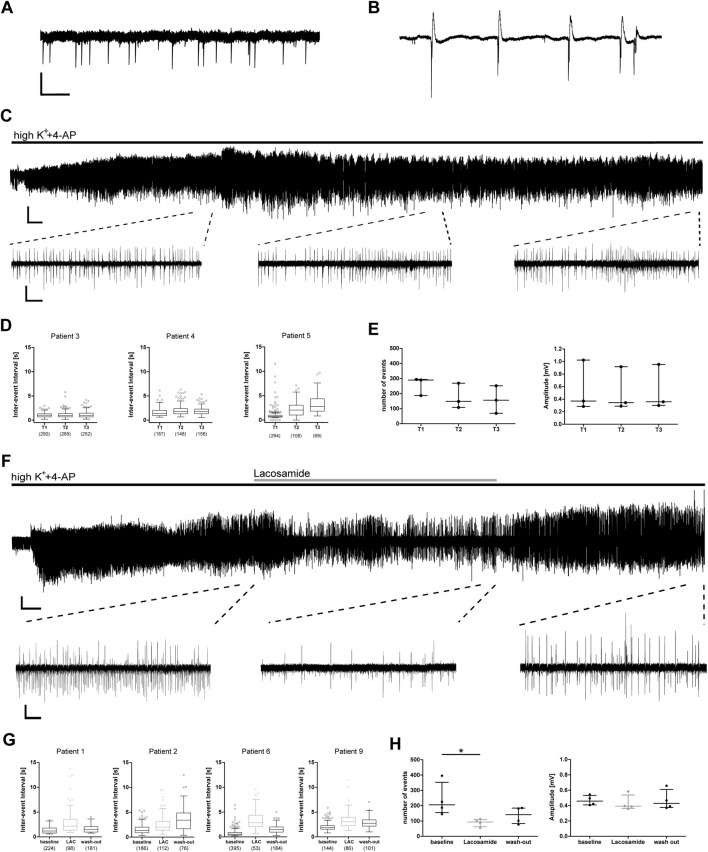
Epileptic burst activity in human slices is stable over long time periods and decreases during application of lacosamide. Application of 8 mM K+ and 100 μM 4-aminopyridine (4-AP) induces two patterns of network activity recorded by field potential electrodes in the CA1 area of human hippocampal slices: interictal spikes (A) and burst activity (B). (C–E) Burst activity is induced a few minutes after application and stable for at least 60 min. (F–H) Induced burst activity decreases during application of lacosamide (LAC). (C,F) Exemplary recording with excerpts of regions used for analysis. (D,G) Inter-event intervals (IEI) of individual recordings shown as box plots with mean and 1.5× interquartile distance. Each dot represents data point outside the 1.5× interquartile distance. Total number of IEI during analyzed time frame are indicated in brackets. (E,H) Summarized results for all patients [number of events and amplitude as mean ± standard deviation (SD)]; each dot indicates one patient. Asterisks mark significant differences as assessed by Friedman test and post hoc with Dunnett’s multiple comparison of groups (p < 0.05). T1, T2, T3 in (D,E) are periods analyzed for each patient, comparable to analyzed times in (G,H) and Figure 3. Scale bars: 0.2 mV, 500 ms (A,B), 5 min (full recording, C), 2 min (full recording, F), 5 s (excerpts, C,F).